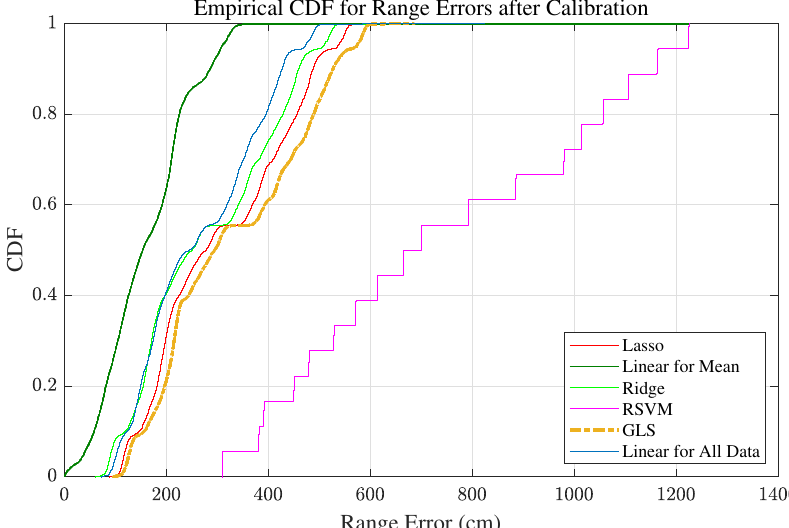
Figure 7. CDF of range errors for the measurements collected in the real environment using the WiFi